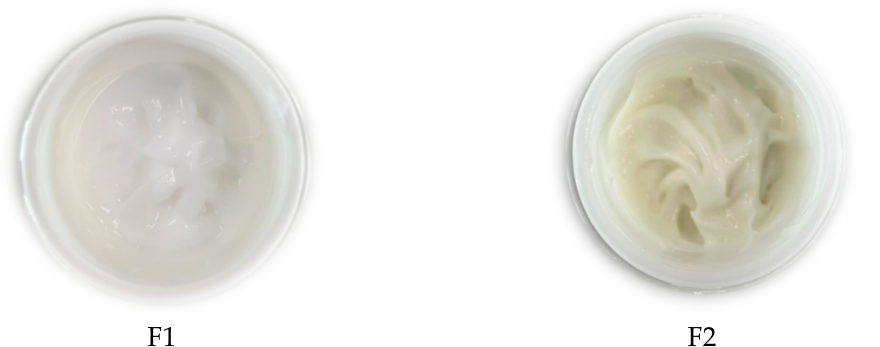
Figure 2. The appearance of liquid crystal creams: without (F1) and with germinated brown rice extract (F2).